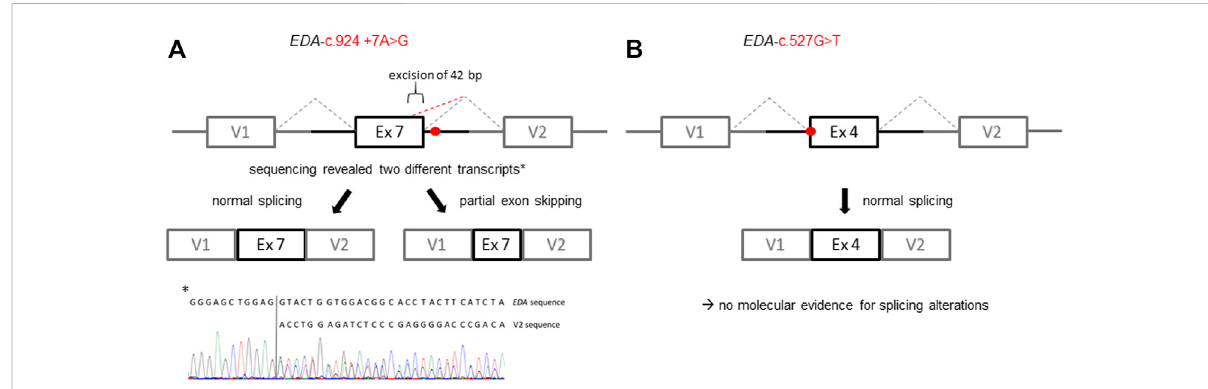
FIGURE 3 Schematic illustration of the exon trapping assays displaying the potential effects of the EDA variants on splicing. (A) Variant EDA -c.924+7A > G spawns two differenttranscripts in vitro indicated by a normally spliced WT sequence and additionally a partially skipped exon (truncation of 42 base pairs; GenBank accession number: ON600878). (B) With regardto thevariant EDA -c.527G > Tthere was no evidence for variant-induced alternative splicing, as only the WT sequence was detectable. V1, vector exon 1; V2, vector exon 2.